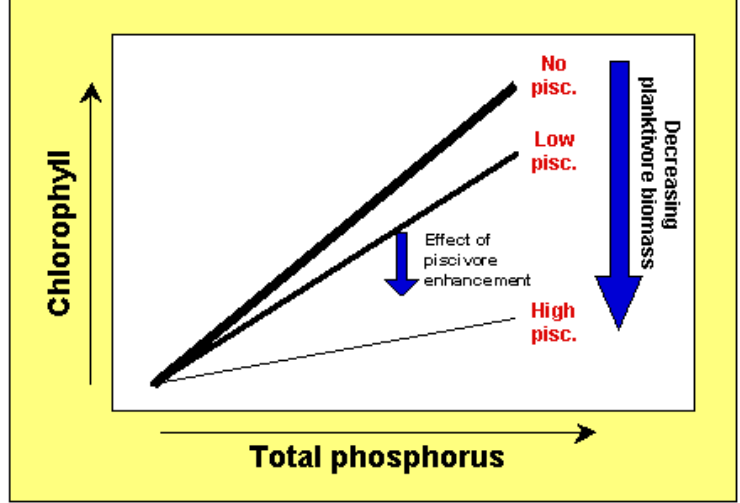
FIGURE 6. Theoretical effect of piscivores on the chlorophyll–total phosphorus relationship in lakes. The heavy line indicates the relationship predicted in lakes that contain planktivorous fish but no piscivorous fish and therefore function as 3–trophic level systems. The thin line indicates the relationship predicted in lakes that contain abundant piscivorous fish and therefore function as 4– trophic level systems. The intermediate line indicates the relationship predicted in lakes that contain low populations of piscivorous fish and therefore function more like 3–trophic level